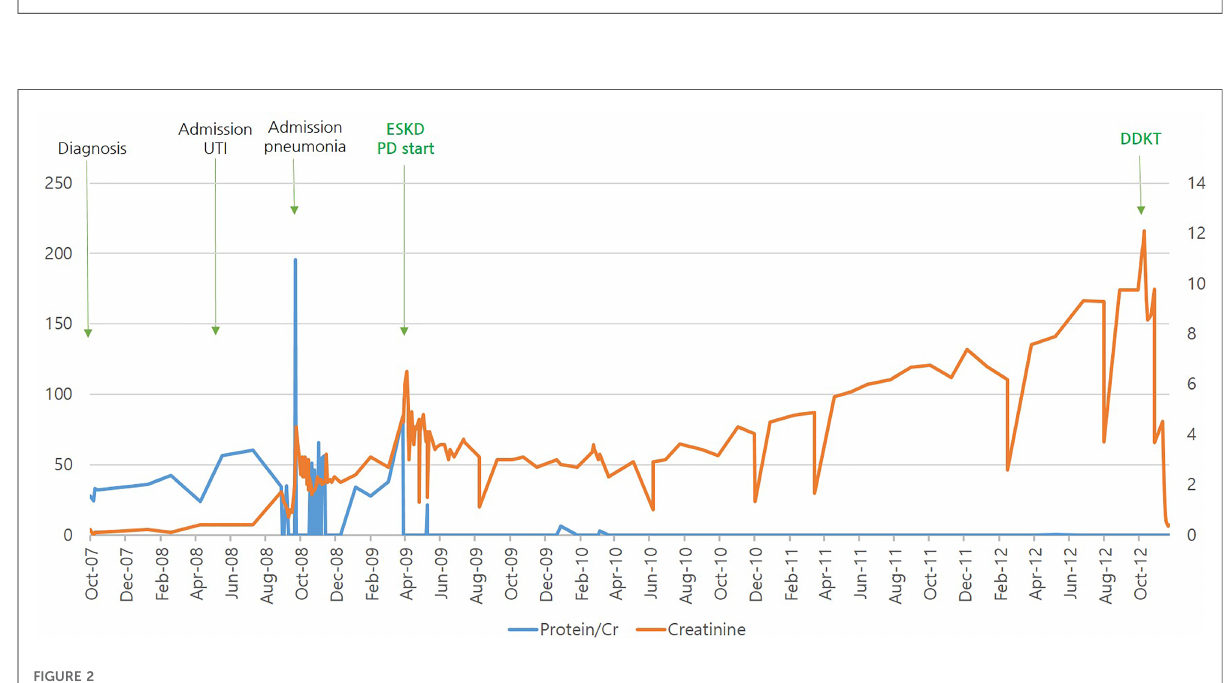
FIGURE 2 Patient ’ s clinical course according to urine protein/creatinine and serum